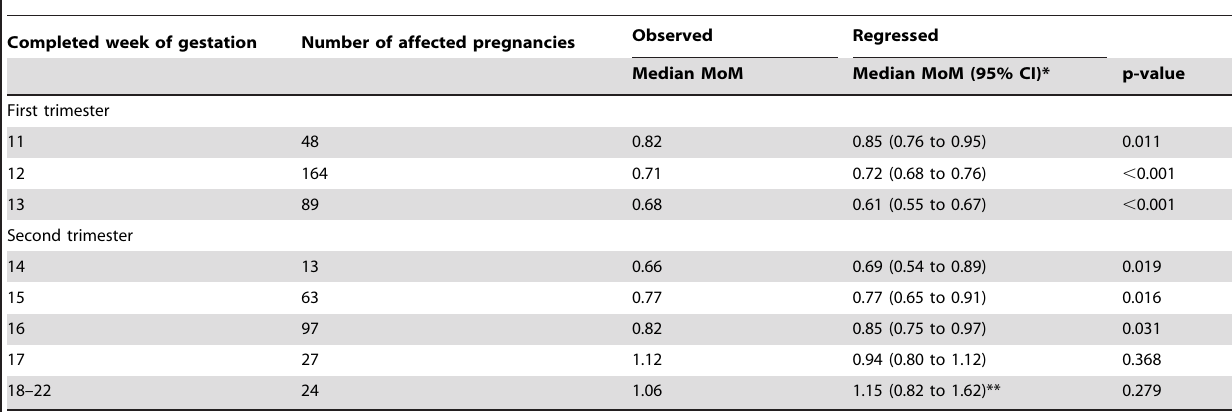
Table 2. Observed and regressed median PlGF MoM in Down syndrome pregnancies according to gestational